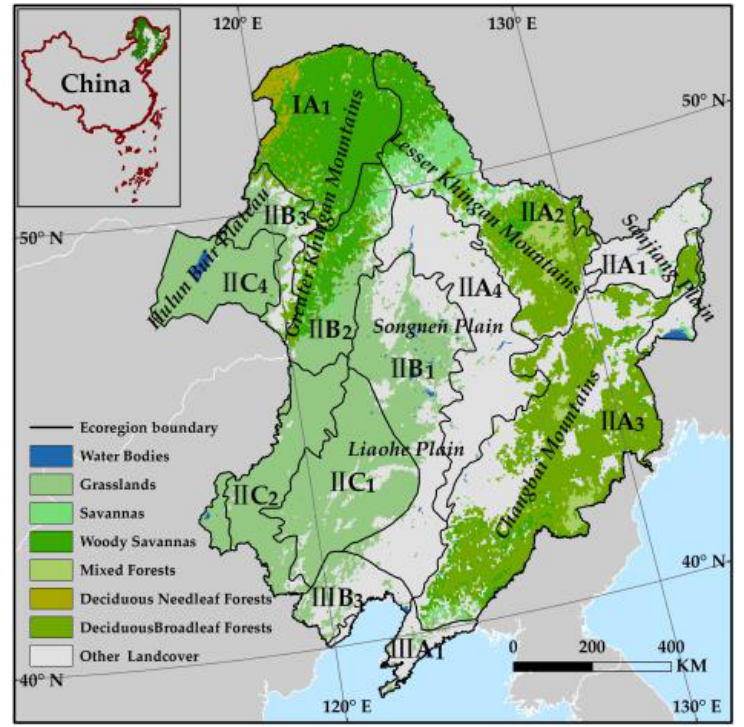
Figure 1. Location of the study area and spatial distribution of main land cover types.